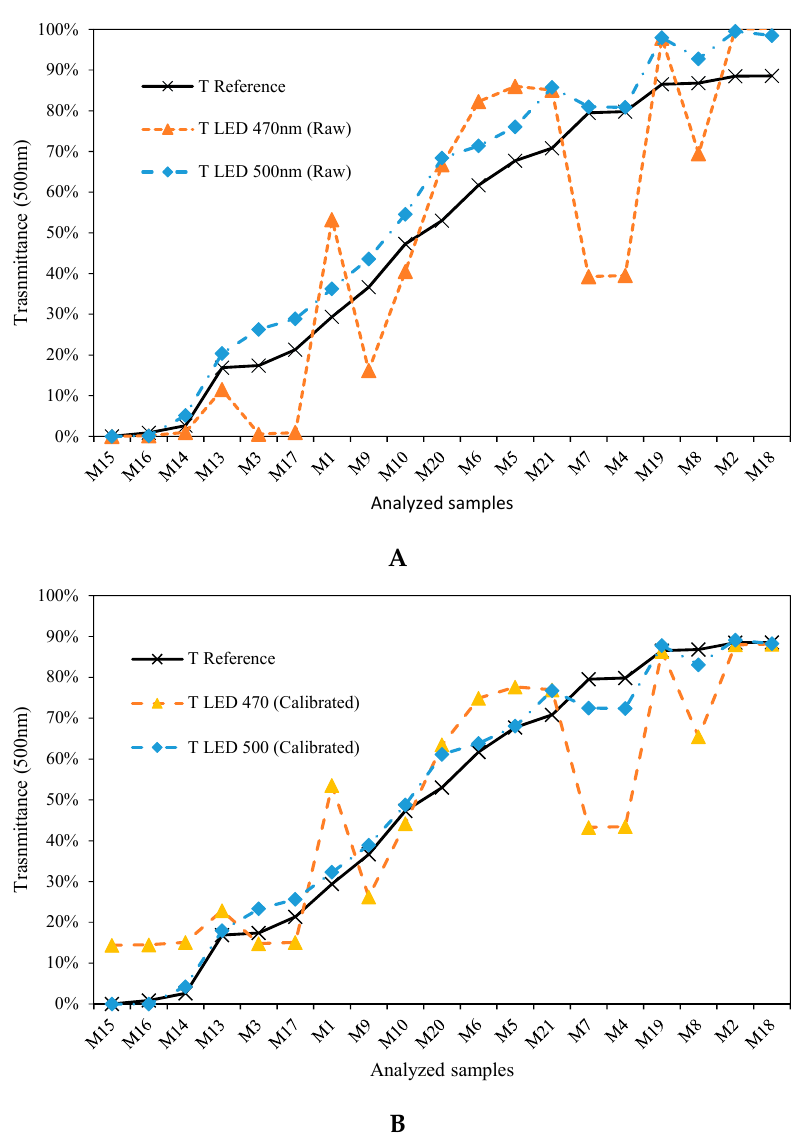
Figure 15. Comparison of the transmittance obtained at 500 nm with the commercial equipment and the prototype developed based on an LED with a peak wavelength of 470 nm and 500 nm. ( A ) Before the calibration process. ( B ) After the calibration process.